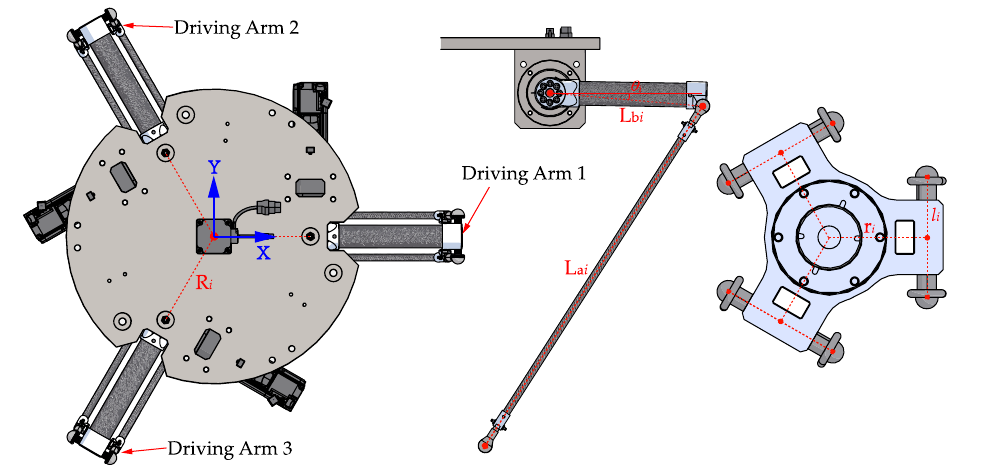
Figure 1. Delta robot 3D model.